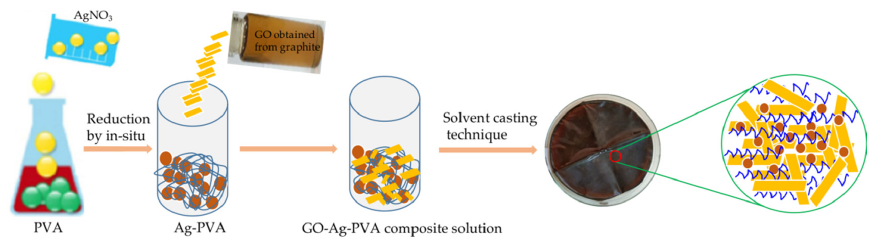
Figure 1. Schematic presentation of fabrication of GO-Ag-PVA nanocomposite